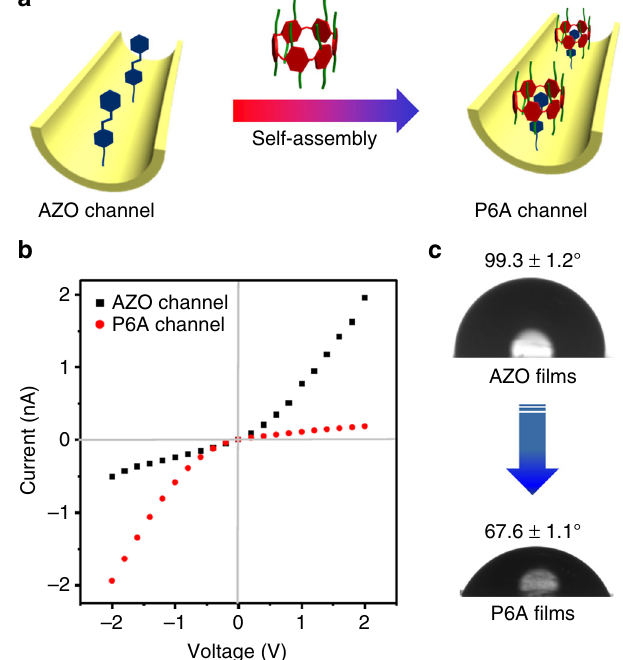
Fig. 3 Fabrication of light-controlled nanochannels. a The construction process of light-controlled nanochannels using a host – guest system. b Current/voltage ( I/V ) curve change in the single nanochannel after each modi fi cation. c Change in contact angle on the PET fi lms after each modi fi cation. These results indicated that the P6A-based